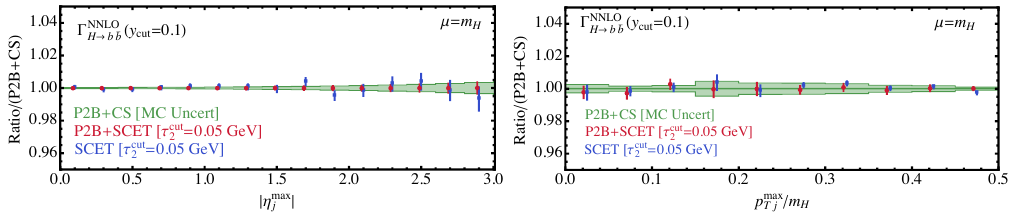
Figure 4 . Comparison of three di(cid:11)erent methodologies for computing the di(cid:11)erential NNLO par- tial width. Shown are results obtained using Projection-to-Born with Catani-Seymour dipoles (P2B+CS), Projection-to-Born with N -jettiness slicing (P2B+SCET), and N -jettiness slicing (SCET). Results are normalized to those obtained using P2B+CS. The left-hand plot shows the pseudo-rapidity, while the right-hand plot shows the transverse momentum of the